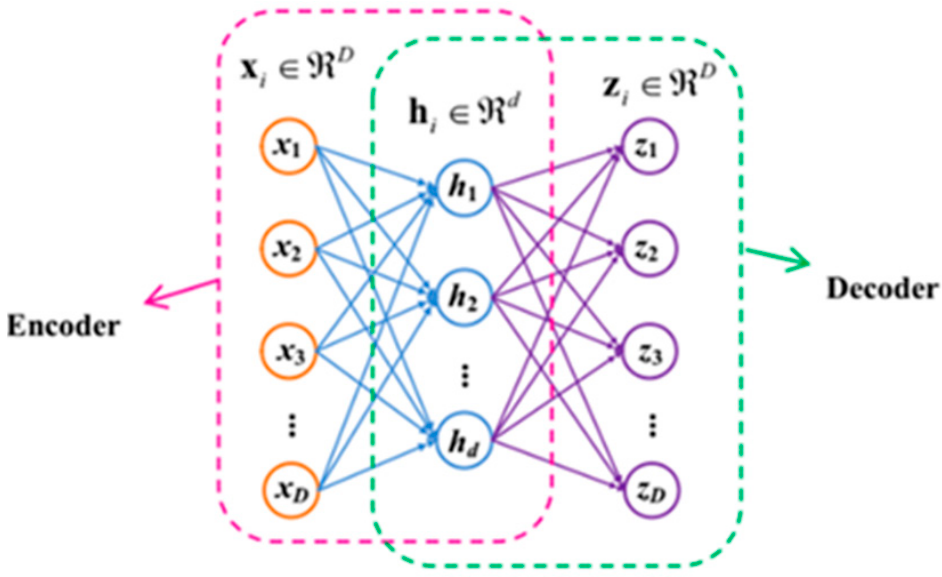
Figure 1. Structure of Autoencoder. Table 1. Parameter used in the proposed